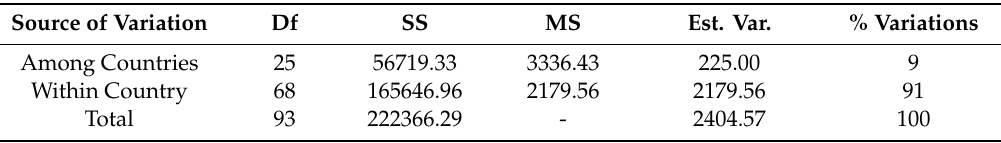
Figure 5. Delta K for the entire safflower population indicating the presence of three subpopulations at K = 3.